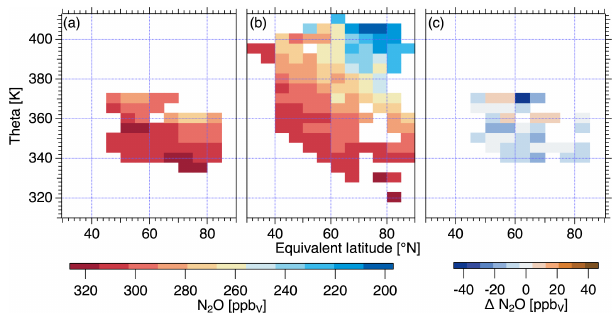
Figure 5. As in Figs. 3 and 4 but for CO. Note the positive differ- ence in CO in panel (c) , indicating an increase in CO in the mea- surement